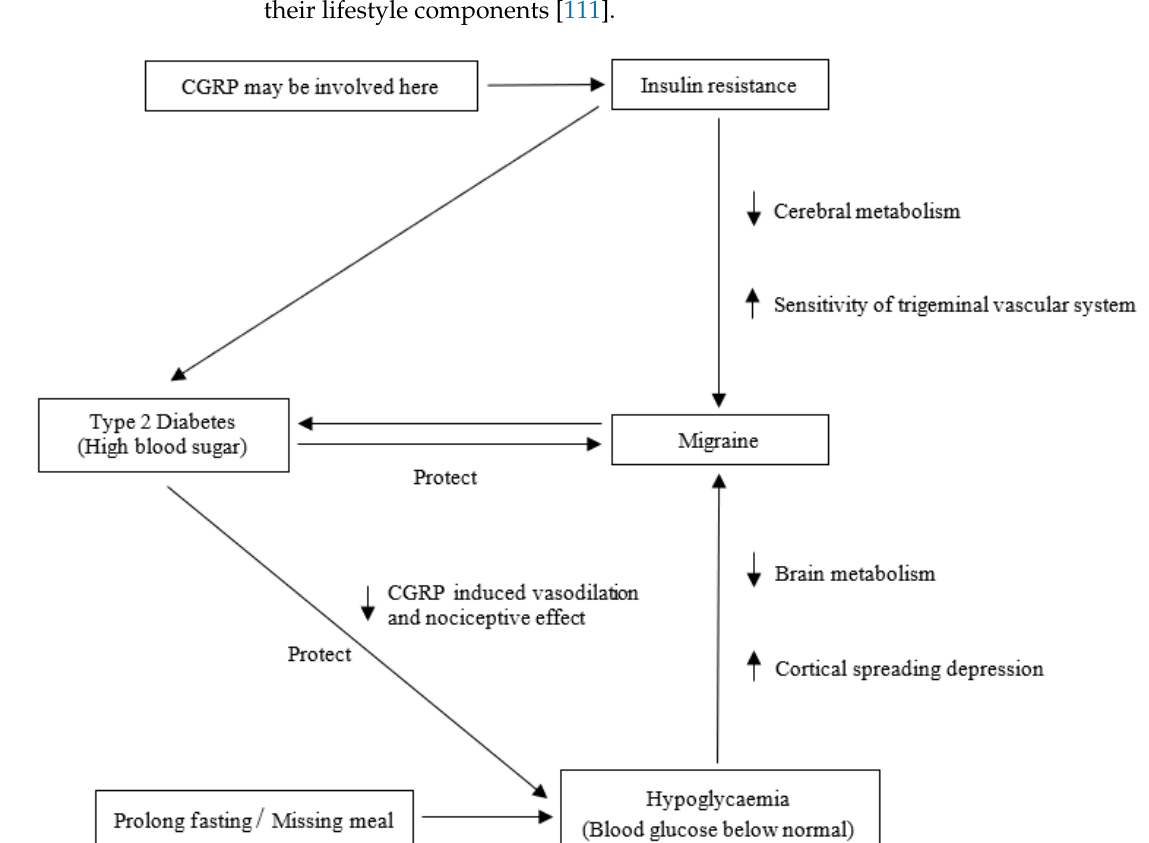
Figure 1. Possible mechanisms describing the relationship between migraine and glucose-related traits. Cortical spreading depression (CSD) in migraine stimulates pain pathways originating in the parasympathetic trigeminal nerve fibres, resulting in the production of calcitonin gene-related peptide (CGRP) [52,84,85]. It is suggested that CGRP expressed in sensory nerves associated with glucose metabolism and plays a vital role in migraine pathogenesis [88]. A change in blood glucose level is another significant aspect in this association where hyperglycaemia makes the cortex more resistant to the start of CSD and accelerates CSD recovery. At the same time, hypoglycaemia has an inverse effect on CSD length [52]. Low blood glucose and sustained sympathetic activity in long-term fasting could diminish existing glucose derived from glycogen generated in presynaptic astrocytes and trigger aura and headache [41]. In migraine, magnetic resonance spectroscopy (MRS) investigations demonstrate hypometabolism or reduced ATP levels due to mitochondrial oxidative phosphorylation (OXPHOS) anomalies, which can lead to migraine attacks [50]. In diabetes, sensory nerve damage due to lower CGRP expression may have diminished CGRP-induced vasodilation and nociceptive effects, which can explain the decreased prevalence of active migraine [101] .